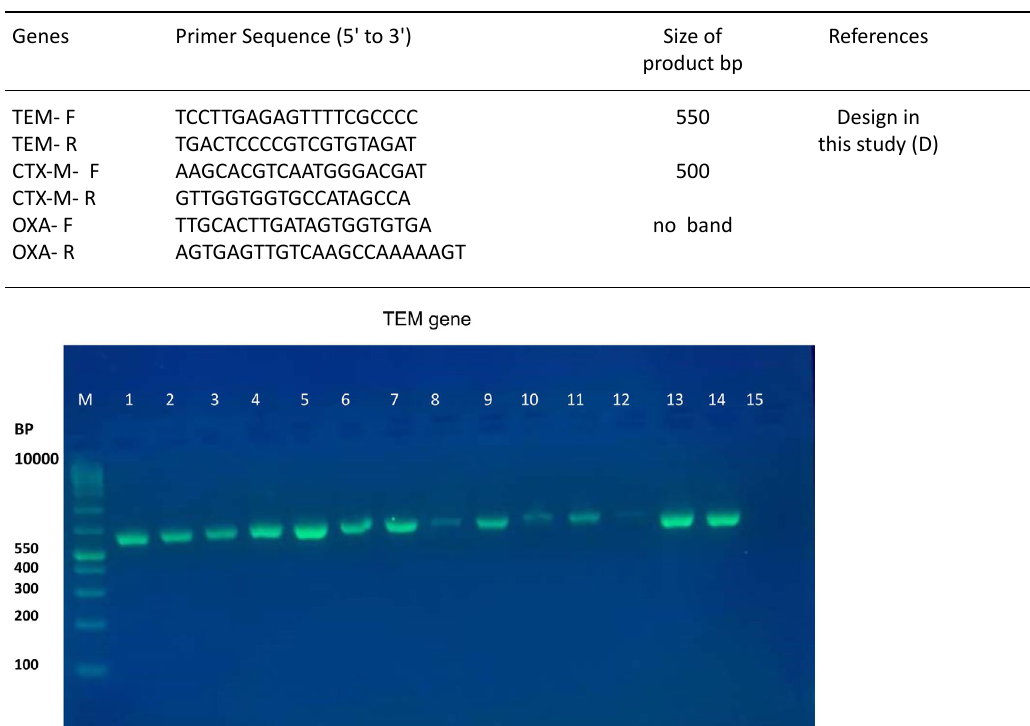
Table 1. Primer design of three ESBL genes and its product